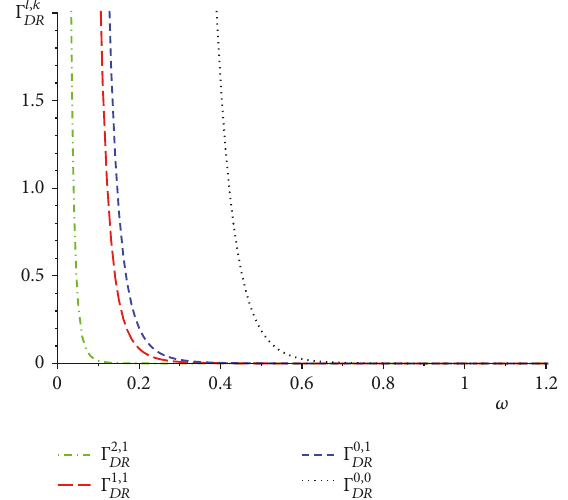
Figure 2: Plots of the DR (Γ 𝑙,𝑘 𝐷𝑅 ) versus frequency 𝜔 . The plots are governed by (65). The configuration of the dilatonic 5𝐷 BS is as follows: 𝜇 = 3 and 𝑄 = 0.2